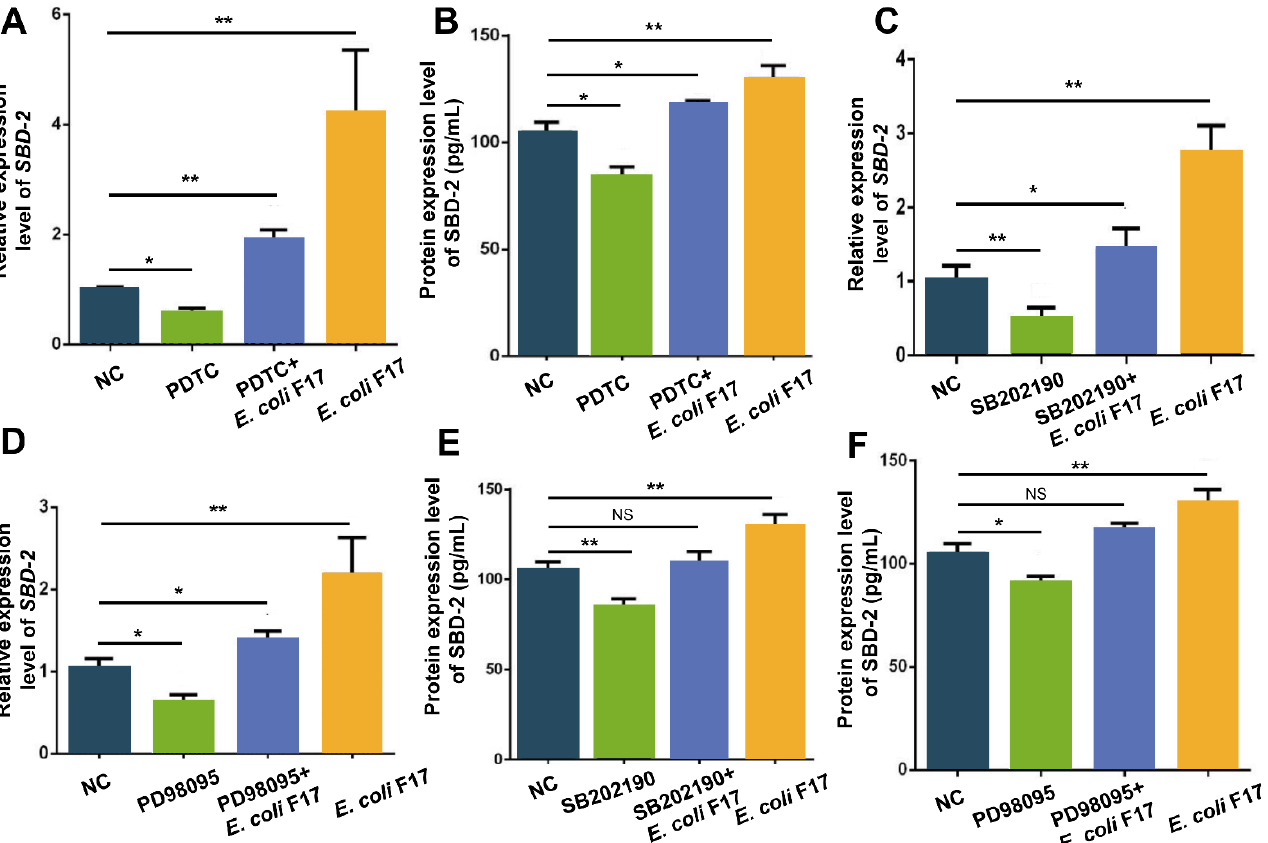
Figure 4. The effect of NF- κ B and MAPK pathways on SBD -2 expression. ( A ) SBD -2 relative expression determined by RT-PCR in OIECs treated with PDTC, PDTC+ E. coli F17 and E. coli F17 compared with non-treated control. ( B ) SBD-2 protein expression determined by ELISA in OIECs treated with NF- κ B inhibitor PDTC, PDTC+ E. coli F17 and E. coli F17 compared with non-treated control. ( C ) SBD -2 relative expression determined by RT-PCR in OIECs treated with p38 MAPK inhibitor SB202190, SB202190+ E. coli F17 and E. coli F17 compared with non-treated control. ( D ) SBD -2 relative expression determined by RT-PCR in OIECs treated with ERK1/2 MAPK inhibitor PD98095, PD98095+ E. coli F17 and E. coli F17 compared with non-treated control. ( E ) SBD-2 protein expression determined by ELISA in OIECs treated with p38 MAPK inhibitor SB202190, SB202190+ E. coli F17 and E. coli F17 compared with non-treated control. ( F ) SBD-2 protein expression determined by ELISA in OIECs treated with ERK1/2 MAPK inhibitor PD98095, PD98095+ E. coli F17and E. coli F17 compared with non-treated control. * p < 0.05, significant difference; ** p < 0.01, extremely significant difference; NS = no difference. Data were shown as mean ± SD, n = 3 biological replicates.